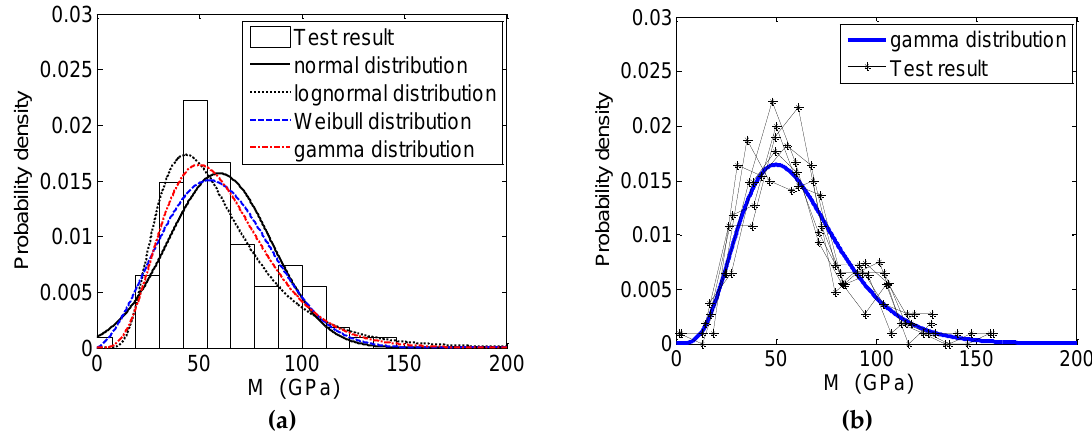
Figure 7. Frequency plots for indentation modulus of the bulk paste: ( a ) histogram of one point out of six and 4 theoretical PDF curves; ( b ) frequency plots of 6 points and the theoretical PDF curve with best estimates.